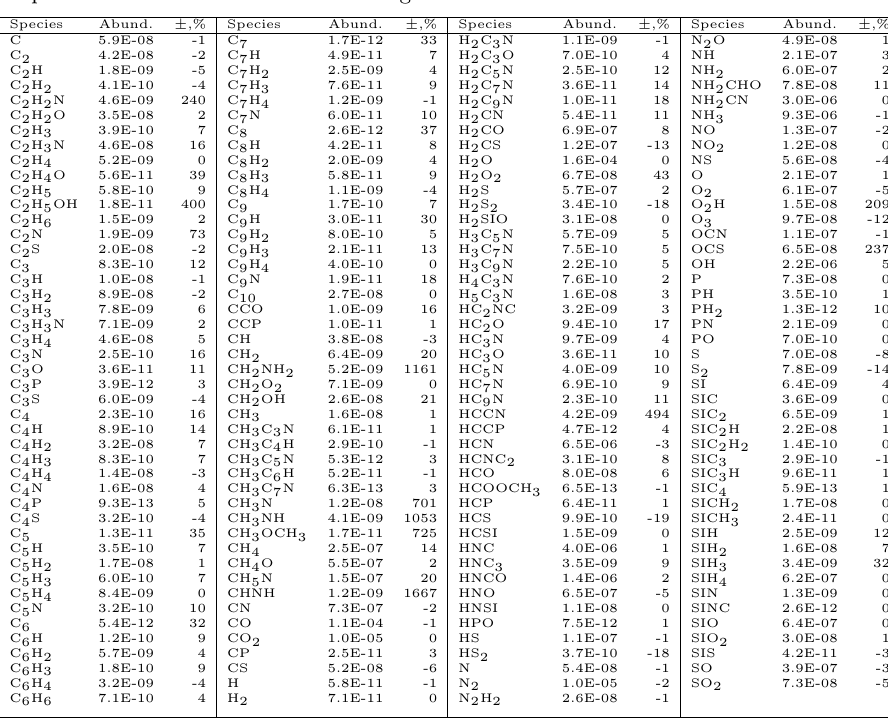
Table 1. Abundances of chemical species, relative to hydrogen, calculated with the CR-induced diffusion model at 1 Myr. The abundance changes ( (cid:6) , in %) with the respect to the reference model are also